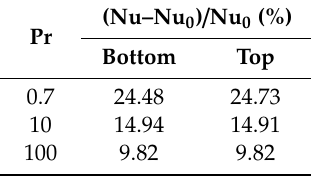
Figure 11. Nusselt number distribution for the cases without and with the magnetic field influence for: ( a ) Pr = 0.7, ( b ) Pr = 10, ( c ) Pr = 100. Table 2. Percentage increase in average Nusselt number value for the studied cases.